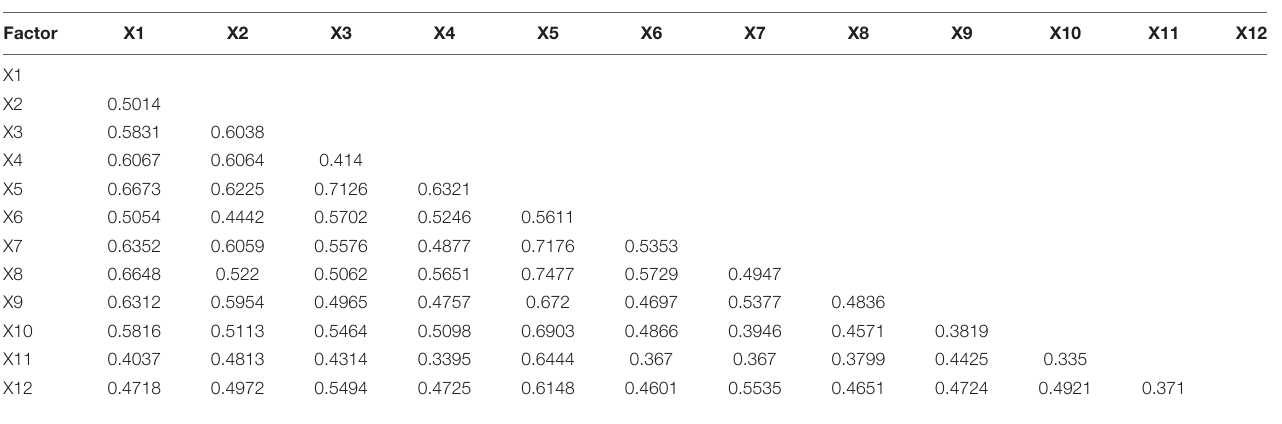
TABLE 4 | Effects of interactions among influencing factors on S NDVI in Guizhou Province,